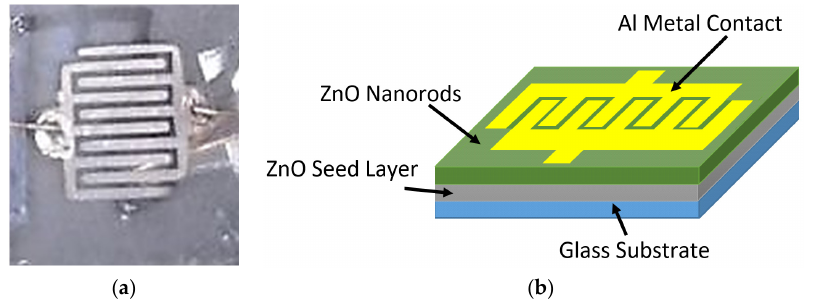
Figure 1. ( a ) Graphical image and ( b ) schematic illustration for the fabricated UV photodetectors (PDs).